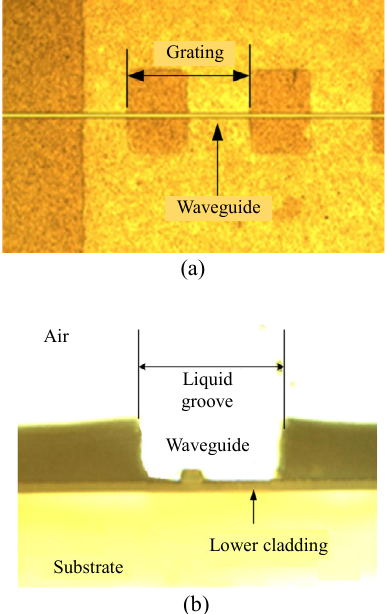
Fig. 2 Microscope images of fabricated chip: (a) without groove etching but with grating etching and (b) cross-section view after groove